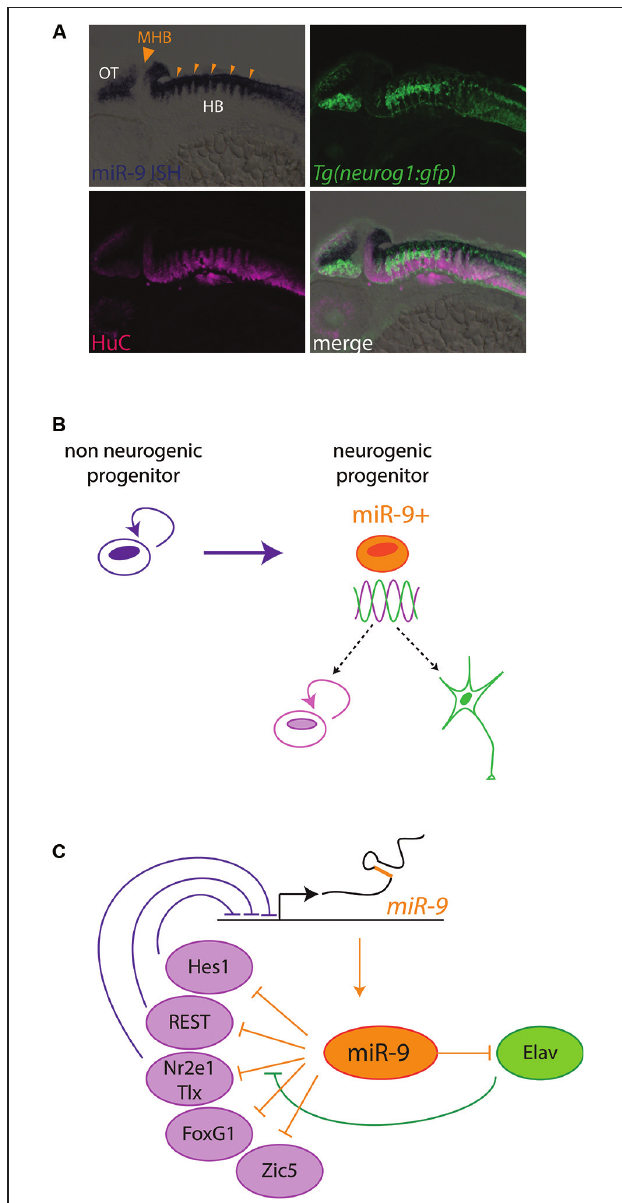
FIGURE 3 | miR-9 regulates progenitorstates in Vertebrates . (A) miR-9 is expressed in active neurogenic zones. Sagittal section through a zebrafish embryo at 48 h post fertilization, showing the expression of miR-9 as revealed by in situ hybridization (blue). miR-9 is expressed at the ventricular zone, and excluded from differentiated neurons expressing the protein HuC (magenta). Its expression is induced in neurogenic areas, where the expression of proneural genes such as neurogenin1 ( neurog1 ) is detected (green). In contrast, miR-9 is excluded specifically from boundary regions, containing long-lasting neural progenitors, such as the MHB (big arrowhead) or rhombomere boundaries (small arrowheads). (B) Functional data suggest that miR-9 promotes the transition from a non-neurogenic progenitor, expressing high levels of Hes1, to a neurogenic progenitor, in which Hes1 levels oscillate. The miR-9 expressing neurogenic progenitor is in an ambivalent state, poised to respond to proliferation or differentiation cues. (C) Scheme representing negative feedback loops between miR-9 and its targets, some of which promoting proliferation (purple) and others promoting differentiation